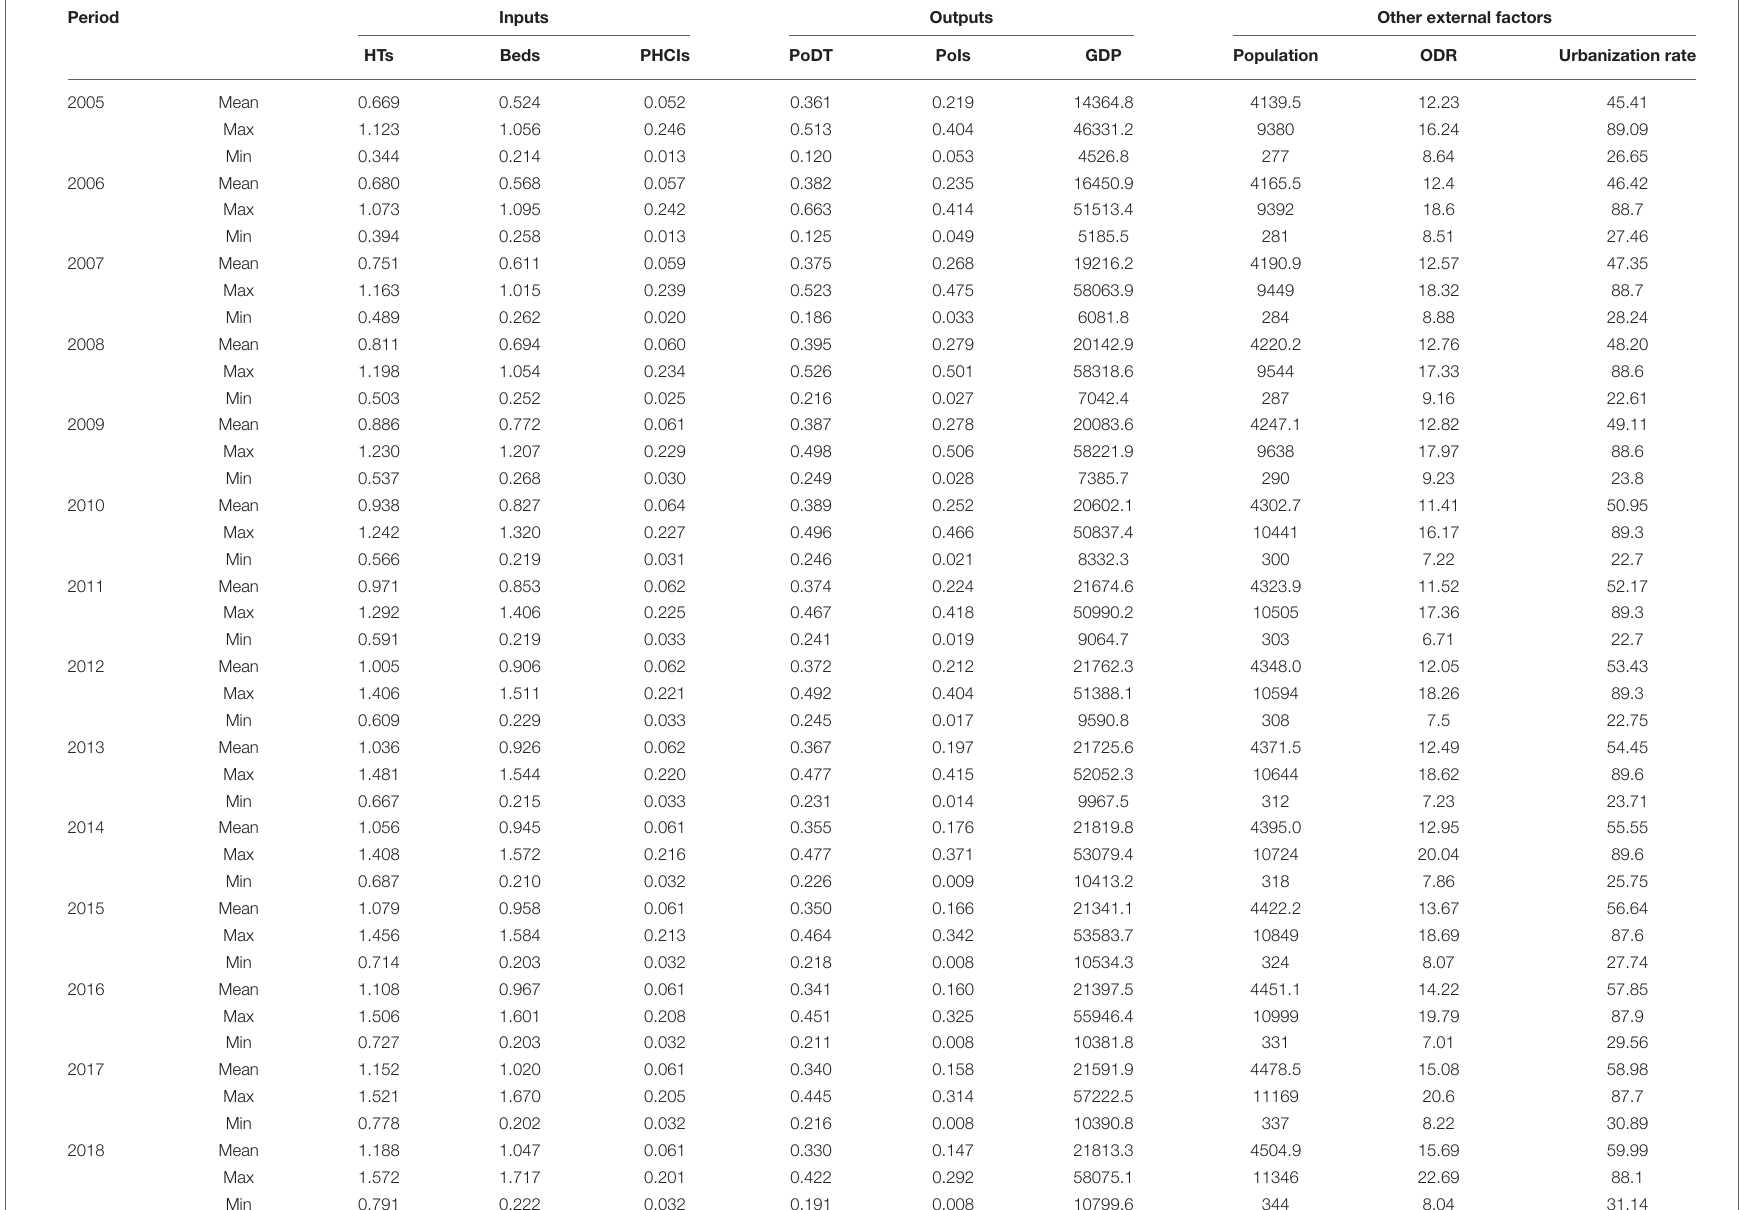
TABLE 2 | Changes in input–output and external factors of PHC in China before and after the reform in 2009.